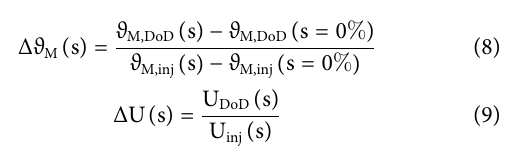
Frontiers in Mechanical Engineering |